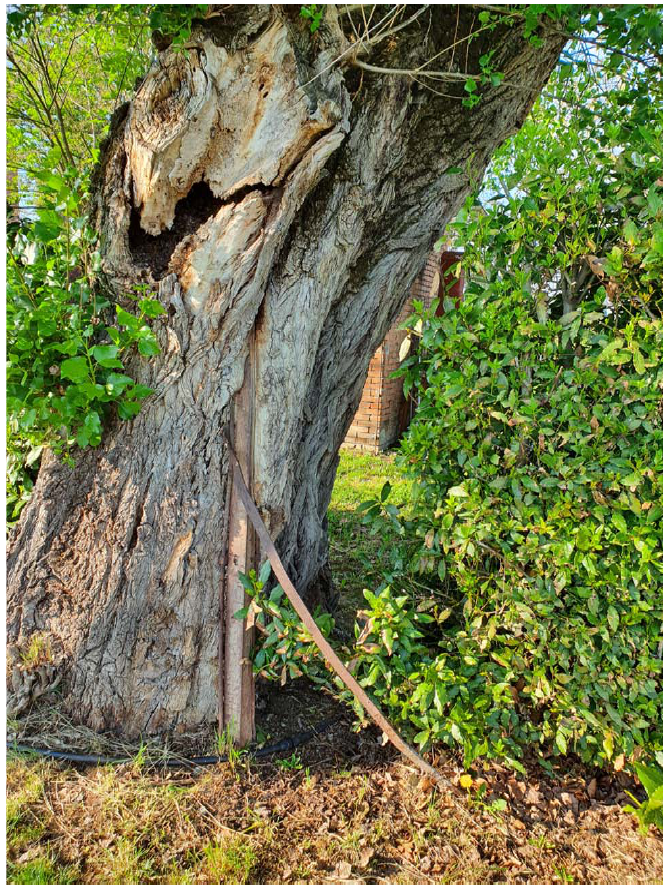
Figure 3. Albero secolare con la ferita di guerra, 2020; © Federica Santoro